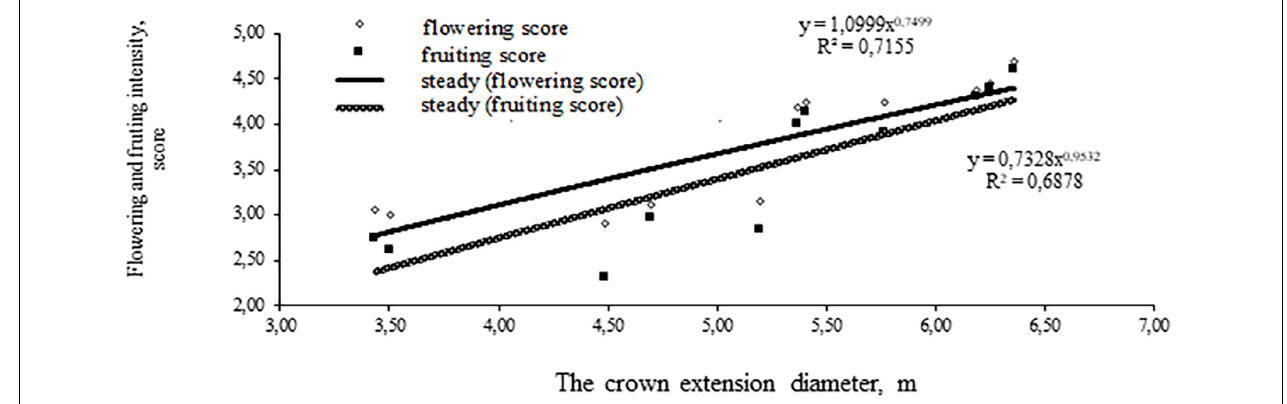
FIGURE 2 | Dependence of tree flowering and fruiting on its crown